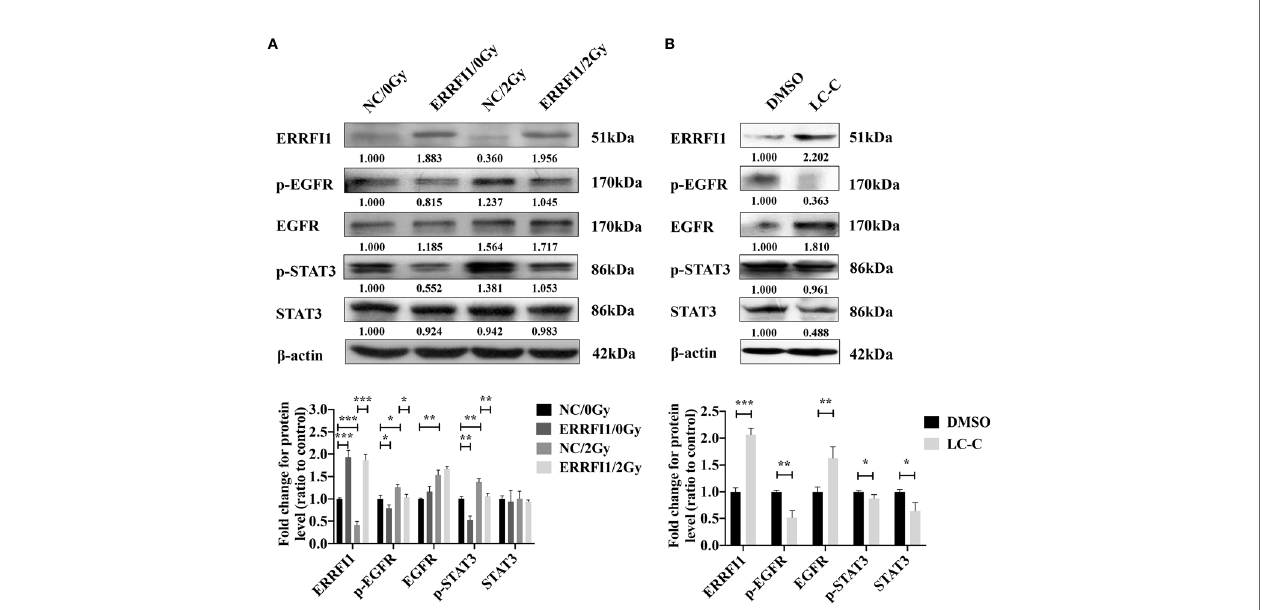
FIGURE 6 | Enhanced radiosensitivity of A549-IR cells by LC-C is associated with decreased activation of EGFR and STAT3 signaling pathways. Western blotting showing the effects of ERRFI1 expression (A) or LC-C (B) on changes of protein expression and phosphorylation in A549-IR cells. *Signi fi cant difference at P < 0.05